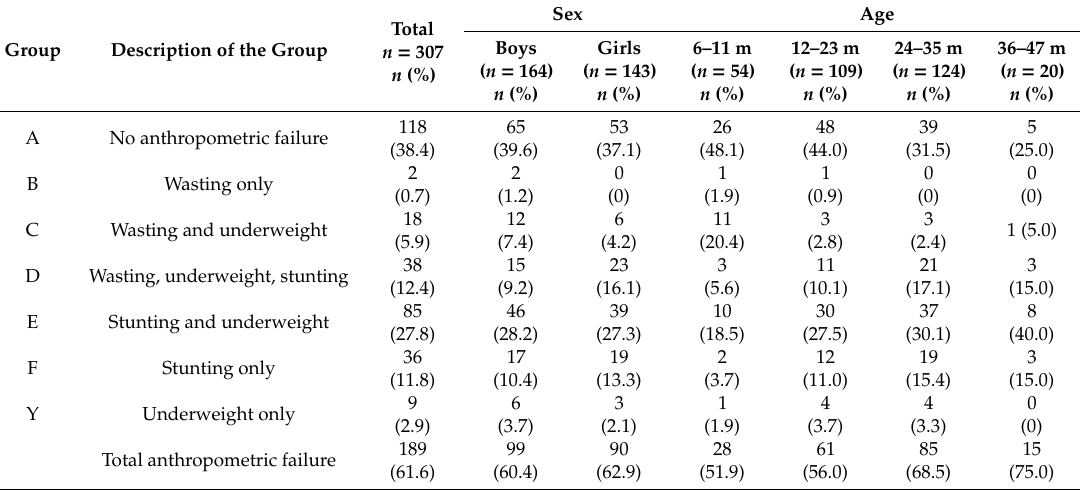
Table 4. Prevalence of undernutrition amongst Santal children according to composite index of anthropometric failure (CIAF).